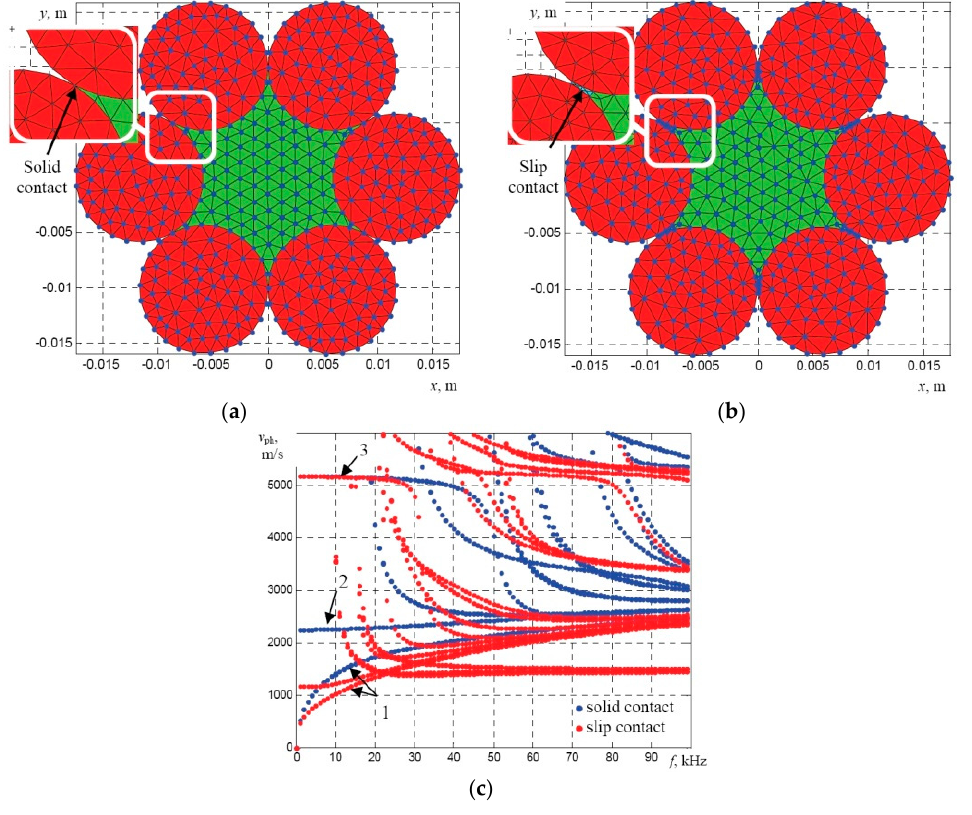
Figure 5. The mesh of the SAFE model of a multi-wire rope in the case of a solid ( a ) and a slip ( b ) contact between neighboring strands and comparison of the phase velocity dispersion curves of the guided wave modes ( c ) propagating along the particular structure: solid contact ( blue ), slip contact ( red ): 1—flexural-like F (1,1) mode; 2—torsional-like T (0,1) mode; 3—axial-like L (0,1) mode.